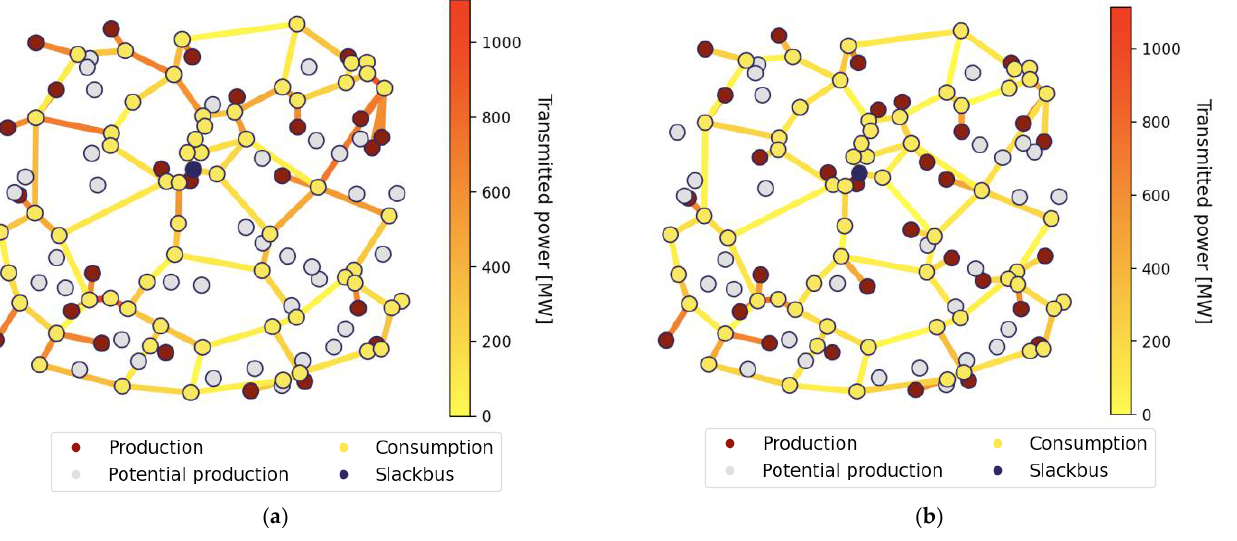
Figure 3. Solar production scenario with a square map area: ( a ) With base case; ( b ) Reference case when the network distance-based value loss was 20%/1000 km.